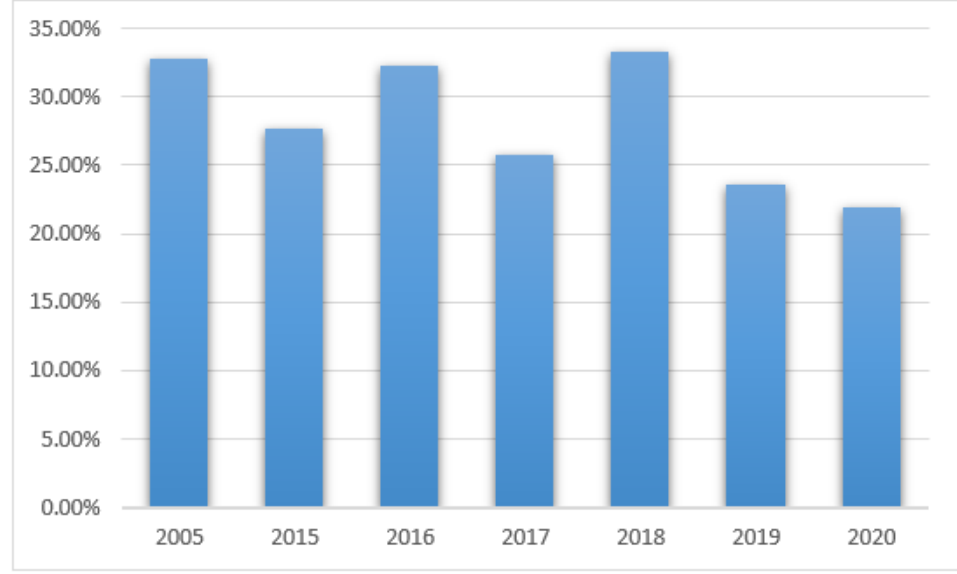
Figure 6. Positive results of mycological tests in NICU patients in the studied years.